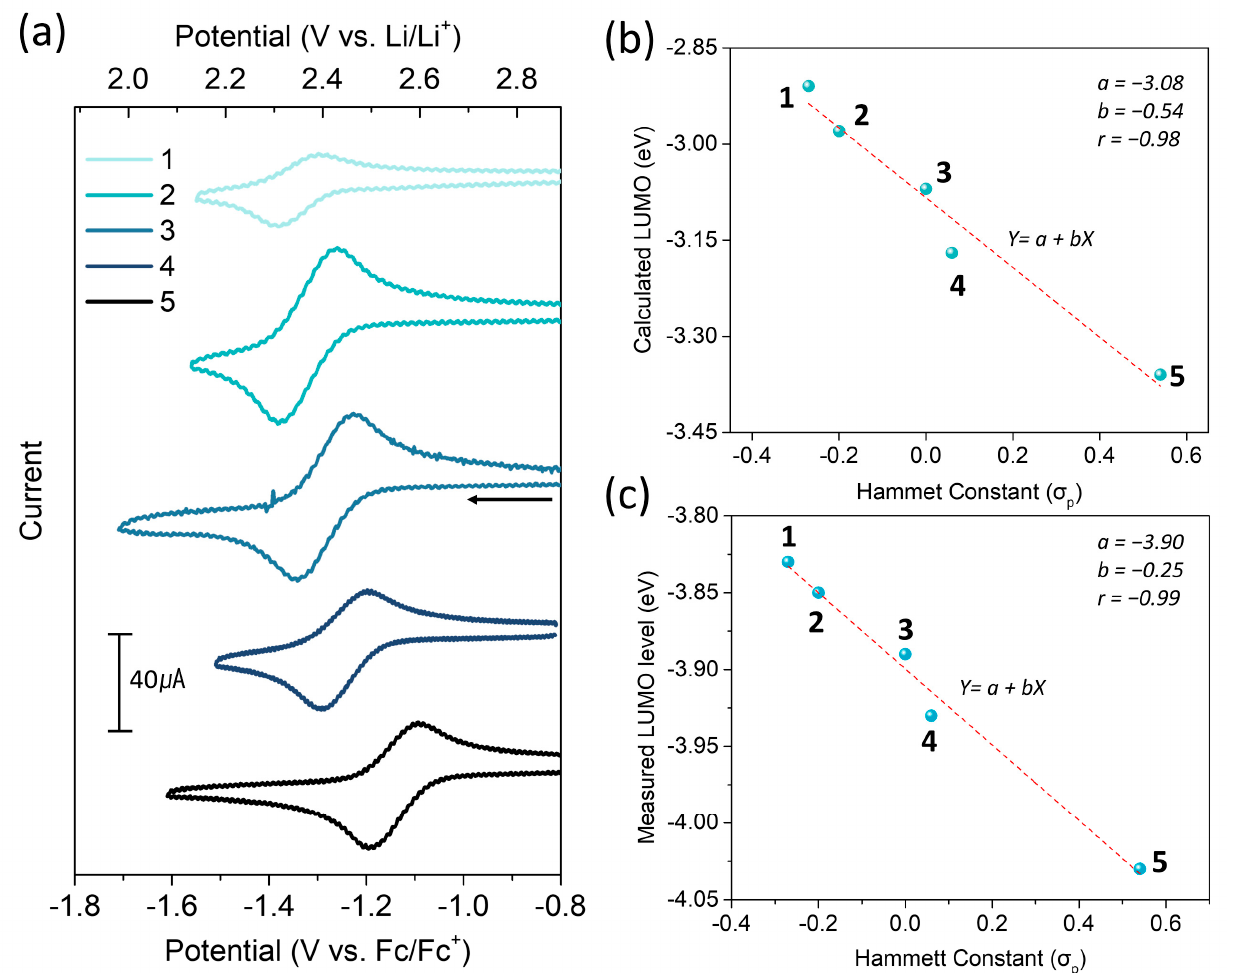
Figure 2. ( a ) Cyclic voltammetry (CV) of the s-tetrazines in 0.1 M [NBu 4 ][PF 6 ] acetonitrile (CH 3 CN) solution. Scan rate (v) was 50 mV s − 1 with a 3 mm glassy carbon working electrode. The concentration of the s-tetrazine derivatives was 2x10 -3 M in CH 3 CN except for 1 (1 × 10 − 3 M), which has lower solubility in CH 3 CN than the others. The linear fitting of ( b ) the calculated LUMO levels of the s-tetrazines in solvated system vs. the Hammett constant of substituents and ( c ) the measured LUMO levels by CV vs. Hammett constant. Table 1. The HOMO, LUMO levels and the redox potentials of s-tetrazines.